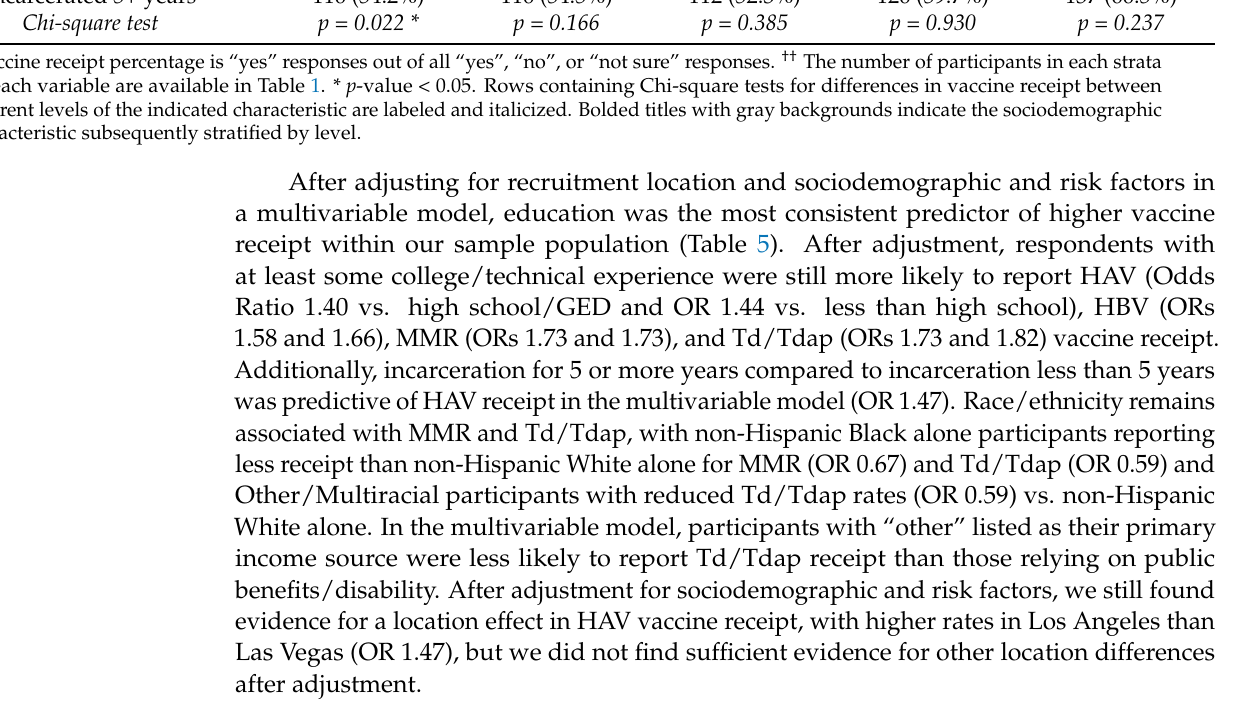
Table 5. Multivariable logistic associations between vaccine receipt † and sociodemographic and risk factors ( N = 1127). Characteristic Location Los Angeles vs. Las